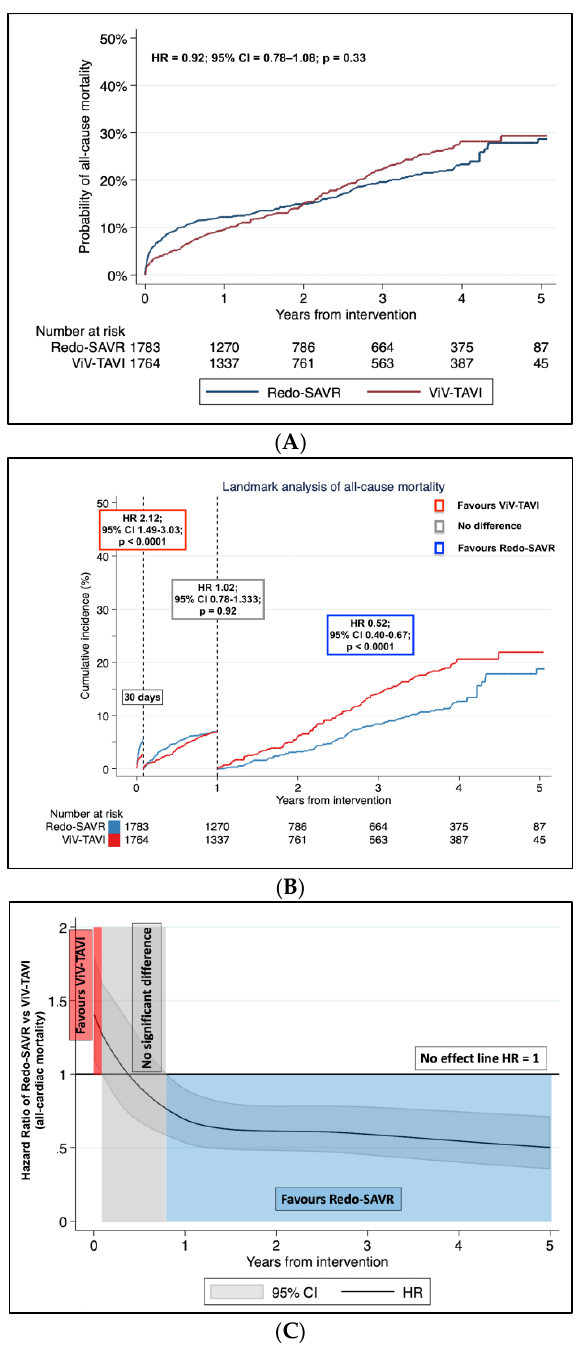
Figure 2. ( A ): Aggregated Kaplan – Meier incidence of all-cause mortality in Redo aortic valve replacement (Redo-SAVR) and valve-in-valve transcatheter aortic valve implantation (ViV-TAVI) . ( B ): Landmark analysis of all-cause mortality in Redo-SAVR and ViV-TAVI. Within 30 days from intervention, ViV-TAVI shows a better outcome compared to Redo-SAVR; no difference between the two interventions is reported within 30 days and 12 months; after 12 months, Redo-SAVR shows a better outcome. ( C ): Analysis of the hazard ratio trend over time for all-cause mortality in Redo aortic valve replacement (Redo-SAVR) and valve-in-valve transcatheter aortic valve implantation (ViV-TAVI). The hazard ratio trend was estimated with the fully parametric generalized survival